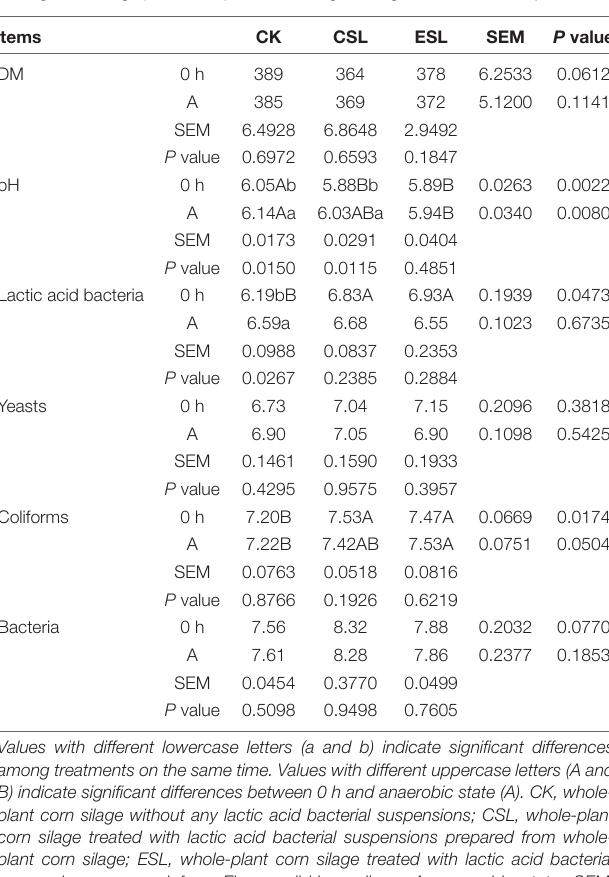
TABLE 2 | Dry matter (DM, g/kg) and microbial counts (log 10 colony-forming units/g fresh weight) of whole-plant corn silage during the initial aerobic